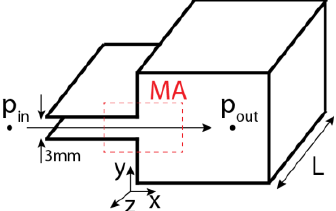
Fig. 4. Basic concept of the narrow channel and the settling chamber measurement. Dashed rectangle represents the investigated area .